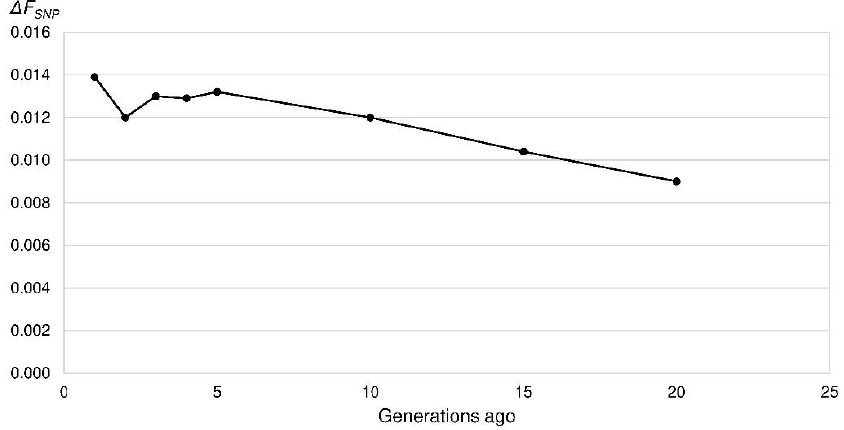
Figure 8. Increase in inbreeding ( ΔF SNP ) in the Polish Lowland Sheepdogs in the last 20 generations based on the linkage disequilibrium among single nucleotide polymorphism (SNP) alleles per chromosome.